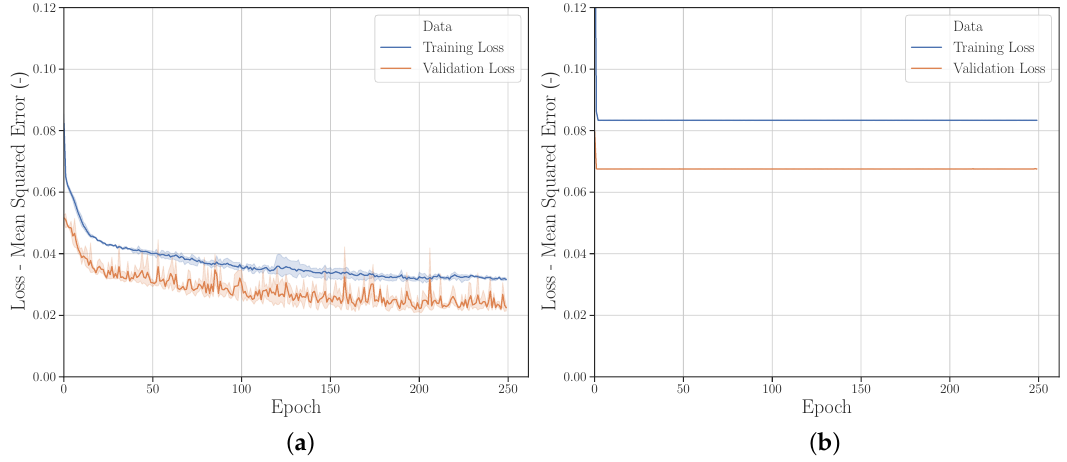
Figure 13. Learning curves with kernel initializer 1 ( a ) HE Normal and ( b ) Zero